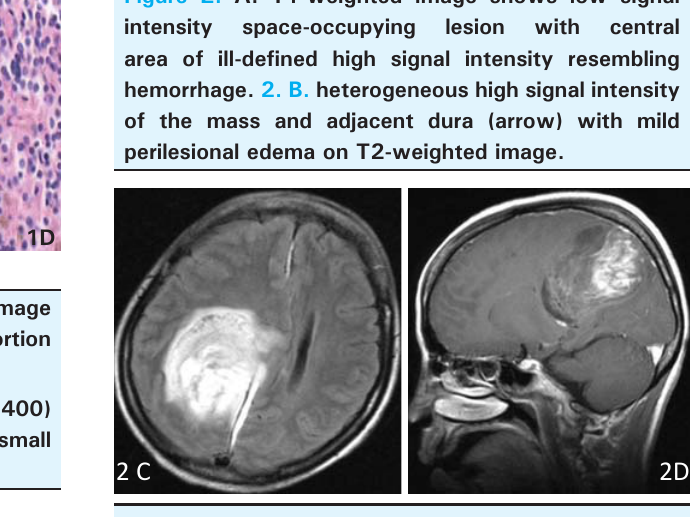
Figure 2. C. FLAIR. 2. D. Contrast nhanced T1- weighted image sagittal view shows heterogeneous mild